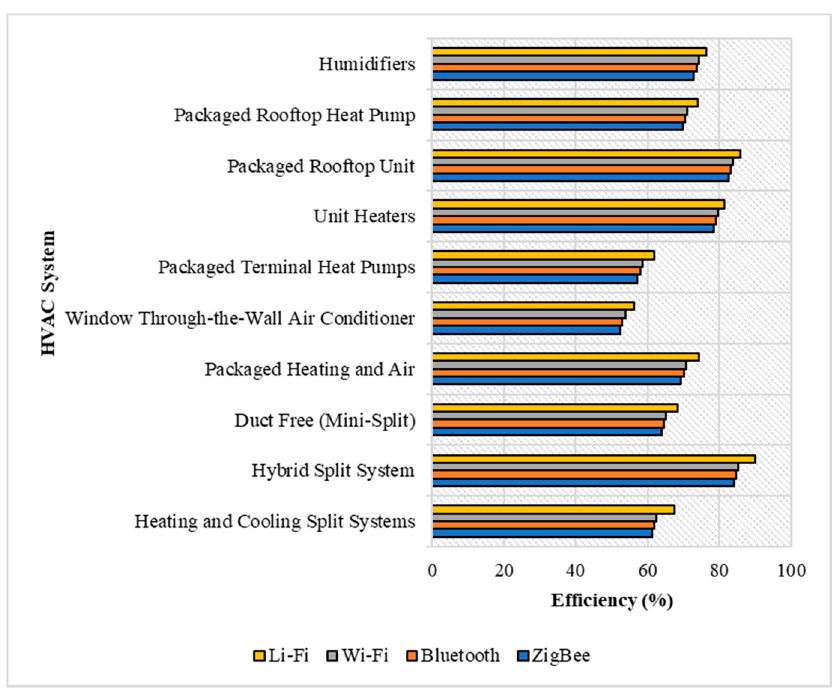
Figure 4. Energy efficiency (%) between various communication protocols using the CRNN system.